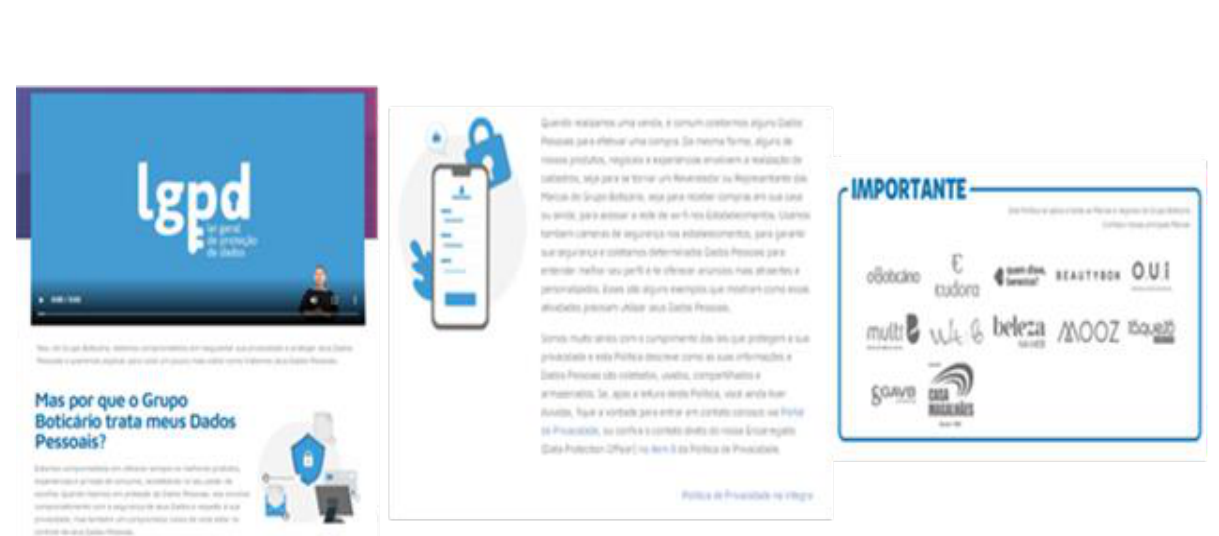
Figure 5. Grupo Boticário Privacy policy